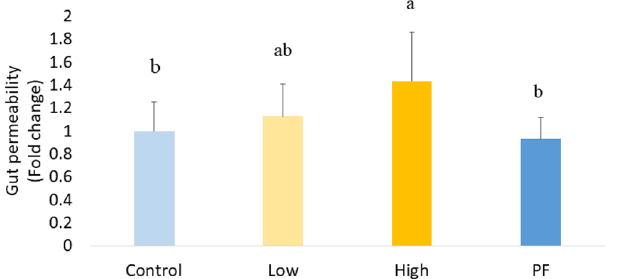
Figure 1. Gut permeability at 5 dpi. Higher concentration of FITC-d in the serum revealed more severe damage to the gut epithelium owing to the Eimeria challenge. a,ab,b Treatments with different letters means a significantly difference between treatments by using Tukey’s HSD test, P < 0.05, N = 10. The relatively level of FITC-d in serum was presented as fold